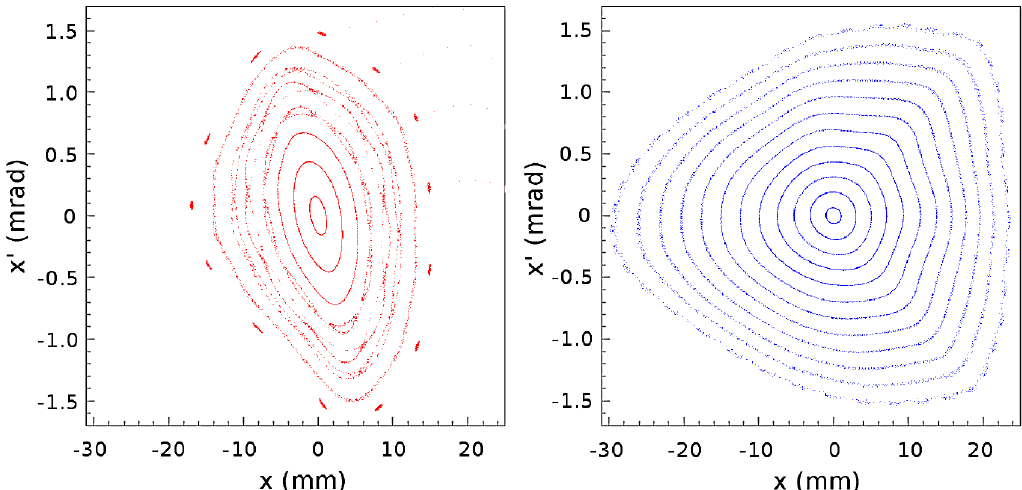
FIG. 15. Horizontal phase space plot of 1000 turns and increasing horizontal starting amplitude at nominal momentum. The vertical starting amplitude is always 1 mm. The dynamic field integrals are not compensated, left, and compensated by L shims,